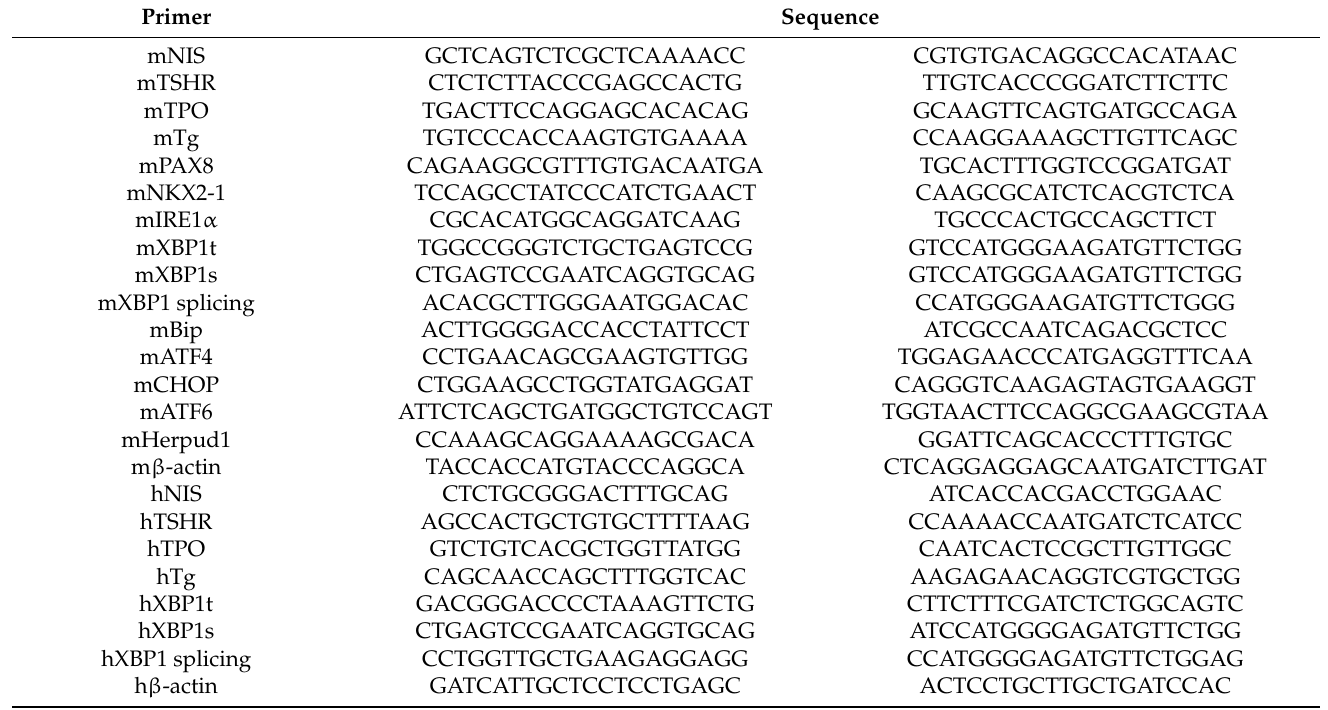
Table 2. Primer information for